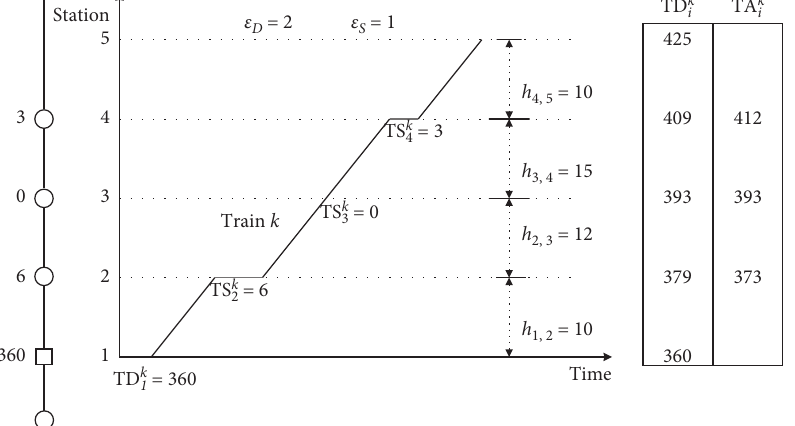
Figure 7: Code rules for chromosomes.